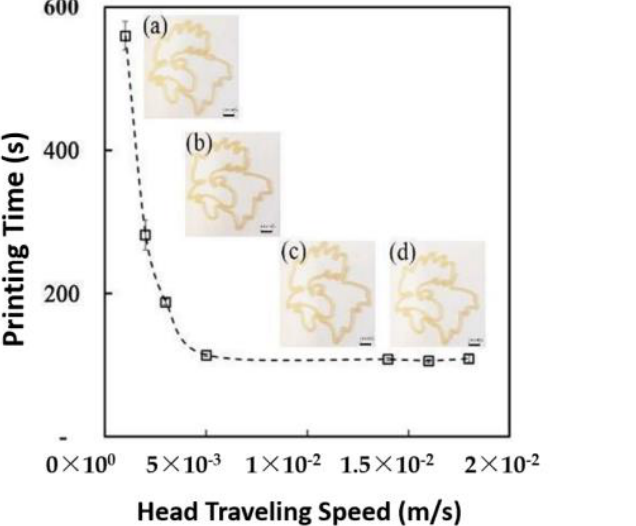
Commented [M3]: Figure updated.